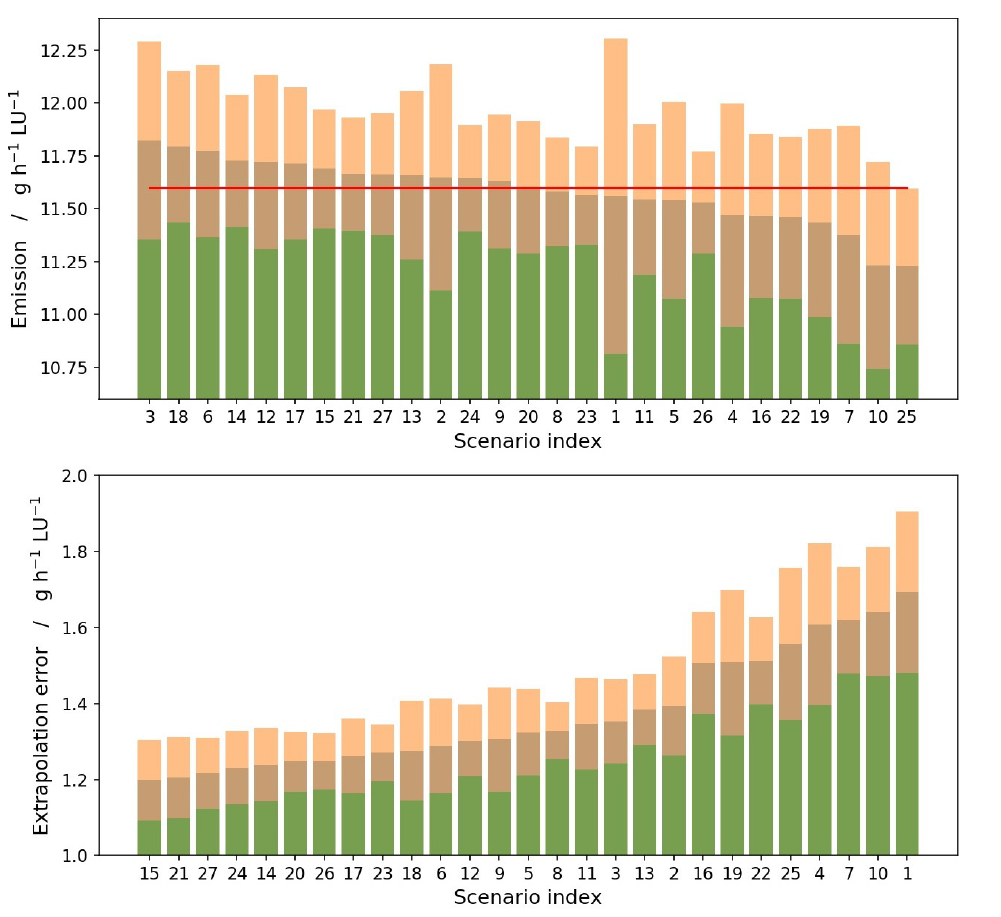
Figure 7. Ranking of the explored scenarios: In the upper diagram, scenario indices are sorted based on the mean predicted emission values, starting with the largest value. In the lower diagram, scenario indices are sorted based on the mean absolute extrapolation errors (MAE), starting with the smallest error. All means were calculated over 30 realizations per scenario and are represented by the border between brown and orange bars. The width of the one-sigma interval is indicated by the orange and brown bars. The red line in the upper panel corresponds to experimental emissions averaged over the 10 month measuring period (11.6 g h − 1 LU − 1